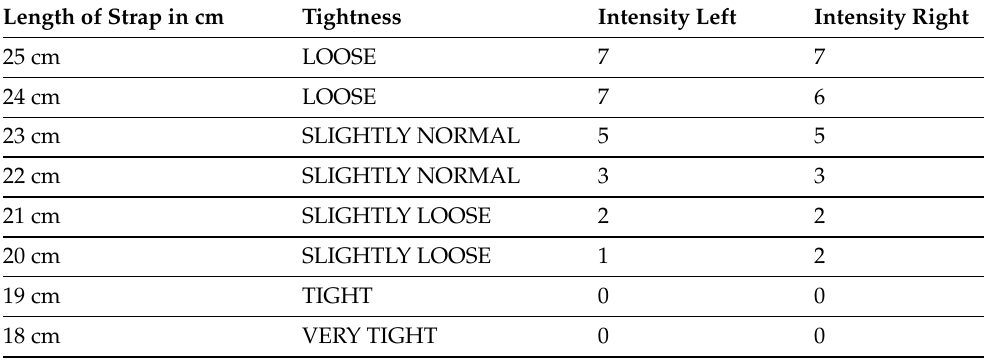
Table 4. Readings of the experiment of light intensity sensors with KN95 mask.